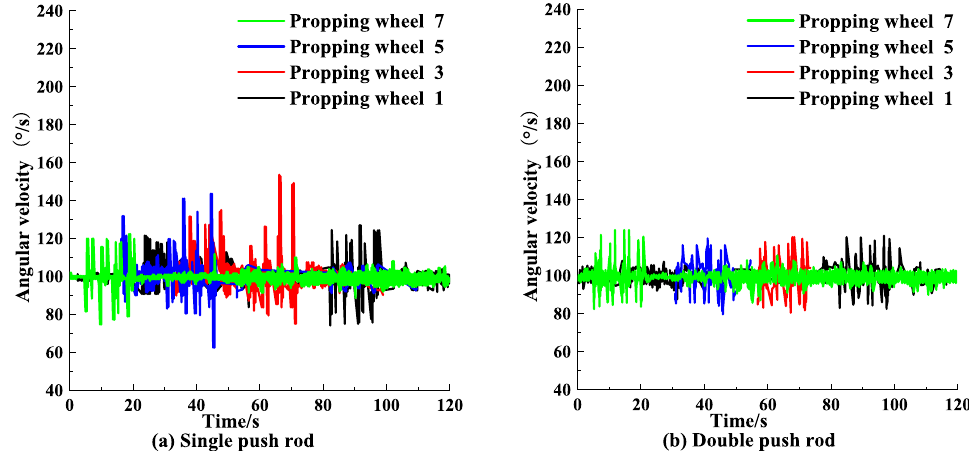
Figure 20. The change of the angular velocity of the support wheel of the single push rod support adjustment mechanism, double push rod − double spring support adjustment mechanism when crossing the well wall deposit and casing wear.